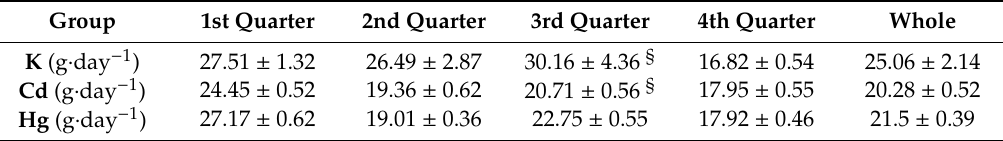
Table 5. Average food intake of female rats ± SD.